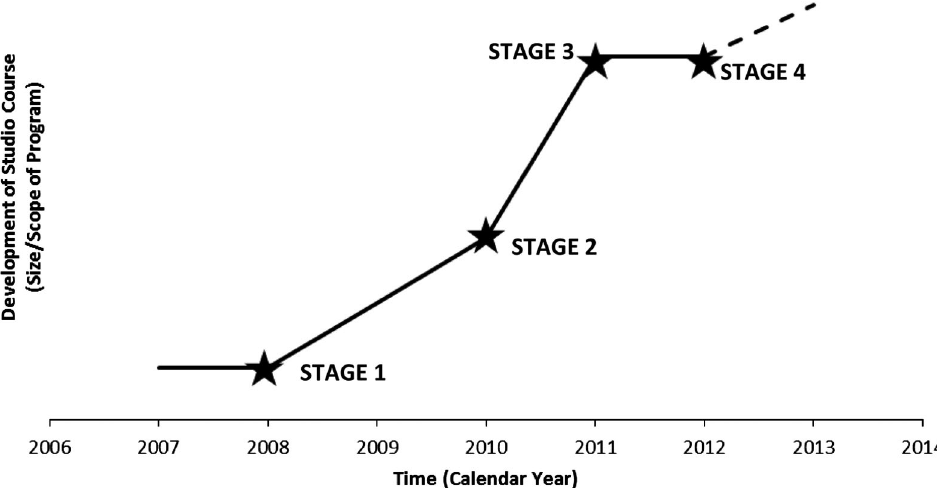
FIG. 2. Kinetics of the studio course effort : The developmental trajectory of the studio physics program is represented by this line graph plotting the change in size of the program over the course of several